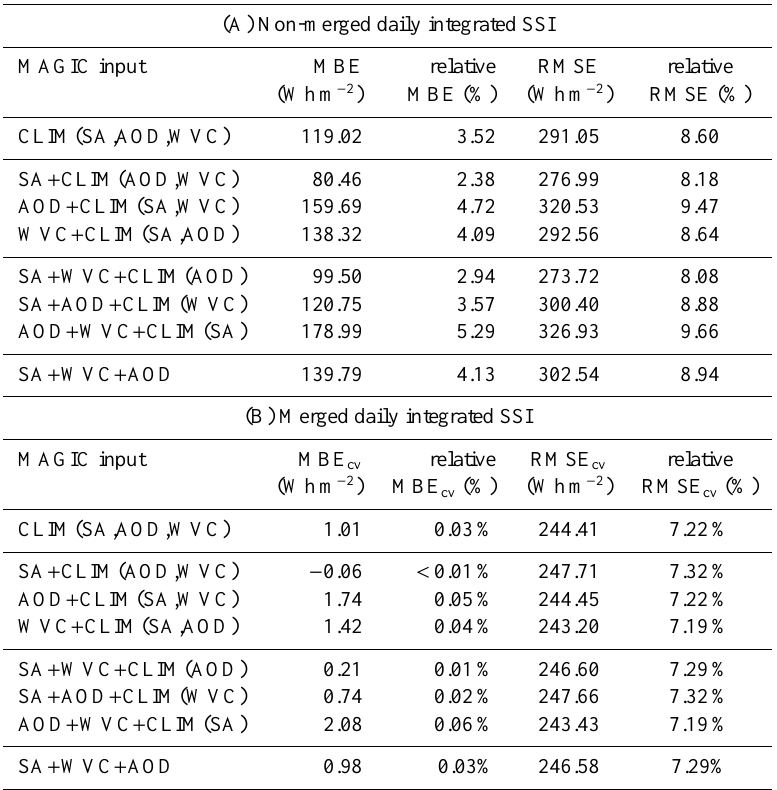
Table 1. MBE and RMSE of (A) non-merged and (B) merged daily-integrated SSI using the MAGIC default climatology and dynamical inputs (i.e., SA, AOD and WVC) versus global solar radiation measurements at 11 stations in Belgium for the year of